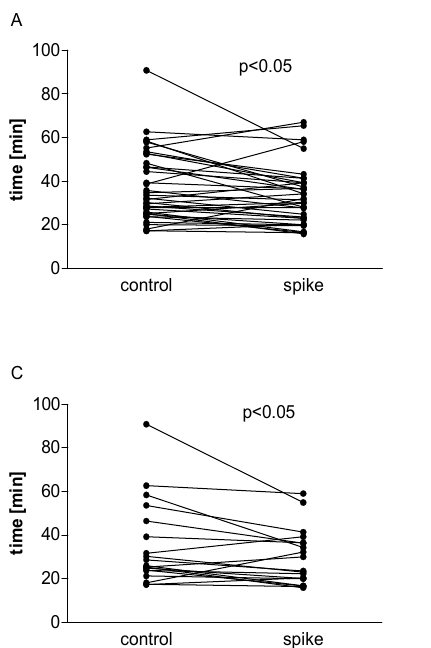
Figure 5. The effect of spike protein on clot retraction. The analysis was performed on the total group of all participant, n = 37 ( A ), in the High Ab-group, n = 18 ( B ), and in the Low Ab-group, n = 19 ( C ). Both the total group ( A ) and the Low- nAb group ( C ) demonstrated significantly shorter times to halving the apparent thrombus area in the presence of spike protein ( p = 0.017 for total group, p = 0.029 for Low- nAb group). The statistical significance of the differences between control vs. spike sample was estimated with the bootstrap-boosted paired Student’s t -test.